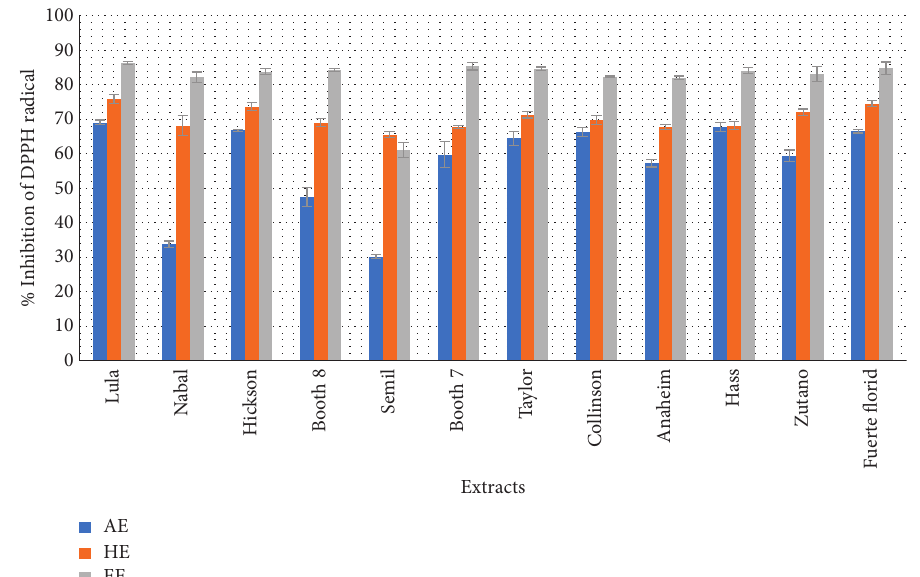
Figure 1: Scavenging capacity of the DPPH radical by aqueous, hydroethanolic, and ethanolic extracts of avocado varieties